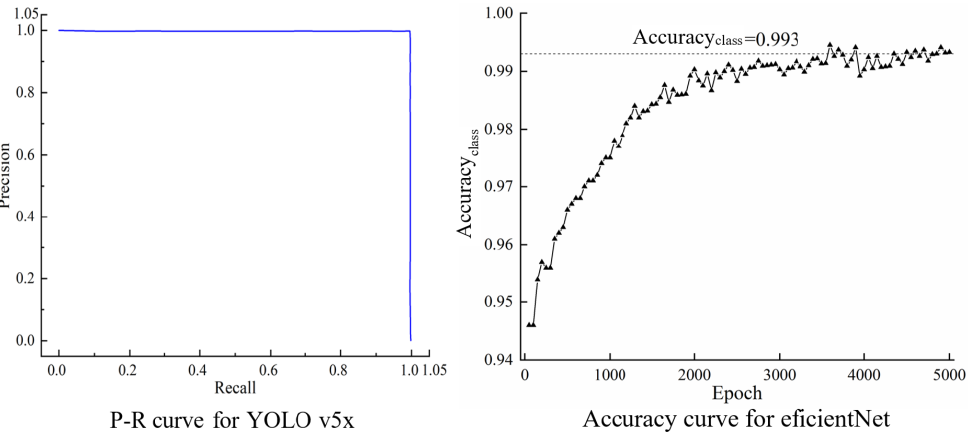
Figure 12. The P-R curve and accuracy for YOLO v5x and efficientNet during